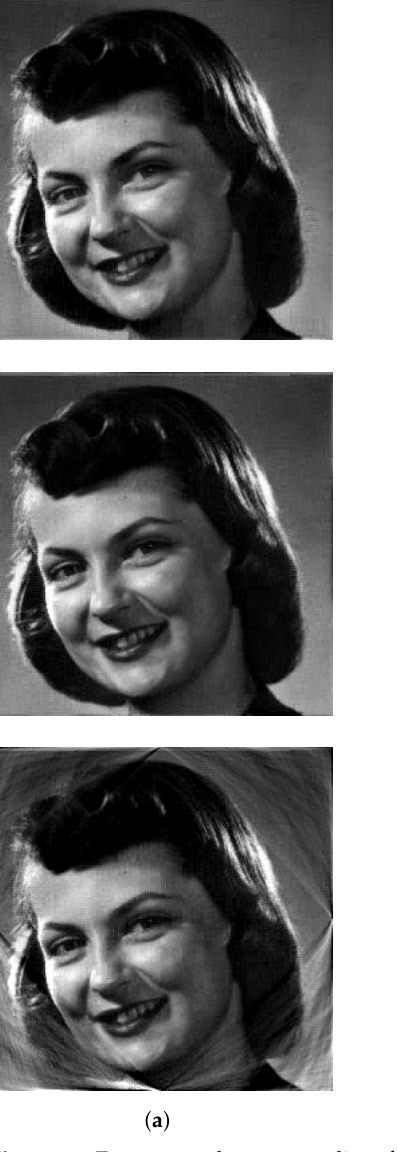
Figure 19. From top to bottom, quality of the inversion for conventional, periodic, and central DRTs. ( a ) Inversion after three iterations; ( b ) Inversion after five